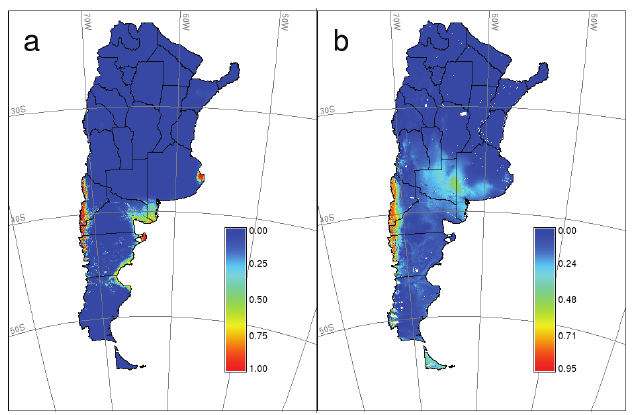
Figure 2. Predicted potential geographic distribution of HPS caused by Andes virus (ANDV) in southern Argentina. ( a ) binomial generalized linear model; ( b ) Maximum Entropy (MaxEnt)